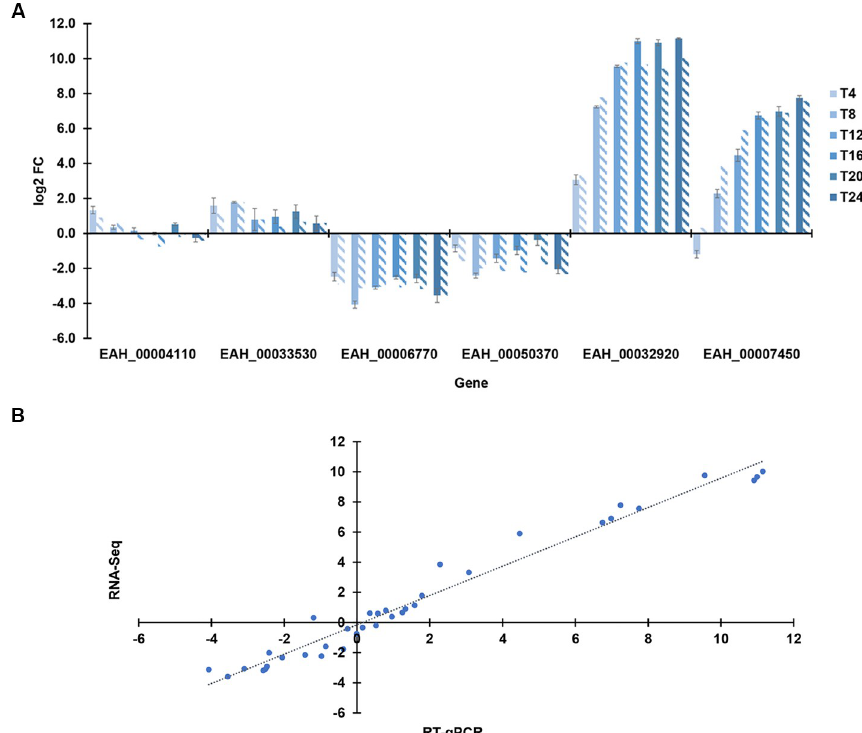
Fig 9. Highly correlated estimates of transcription from RNA-Seq and RT-qPCR assays. (A) Temporal changes in expression of genes selected for validation by qPCR. Log2 fold change (FC) of each gene estimated by each method side by side. Bars with diagonal stripes indicate RNA-Seq data. Expression for each time point is depicted relative to initial transcription level (T0). Note that these six genes include ones with stable, decreasing, and increasing expression through time. Error bars depict variance among RT-qPCR estimates among biological replicates. (B) Correlation of expression as estimated from RT-qPCR and RNA-Seq for six genes at each of six time points. Gray dots indicate regression